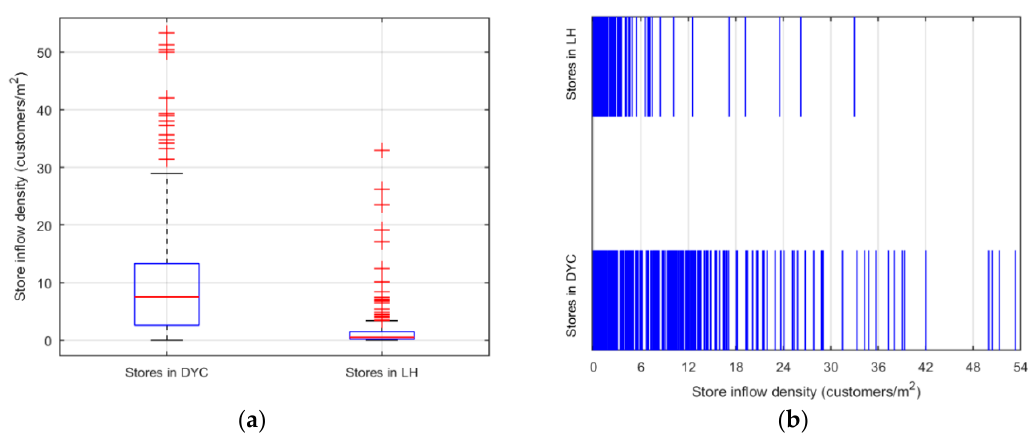
ISPRS Int. J. Geo-Inf. 2020 , 9 , x FOR PEER REVIEW Figure 8. Boxplot ( a ) and rugplot ( b ) of store inflow density in two shopping malls.